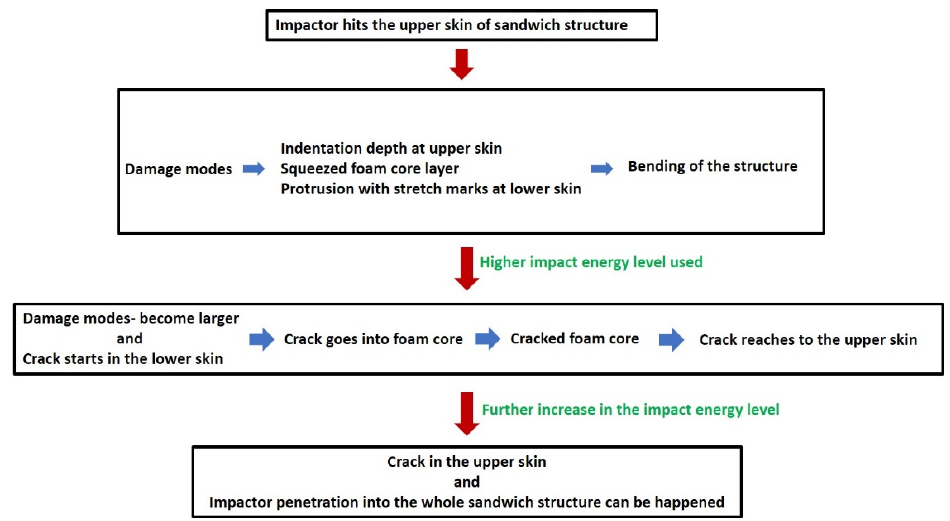
Figure 6. Progression of impact damage (a-e positions of interest) for reprocessed sandwich struc- ture at 30 J. Red arrows indicate the cracks. Positions of interest (a-e) represent the different points of the damaged area of impacted specimen, shown in the upper image of this figure.